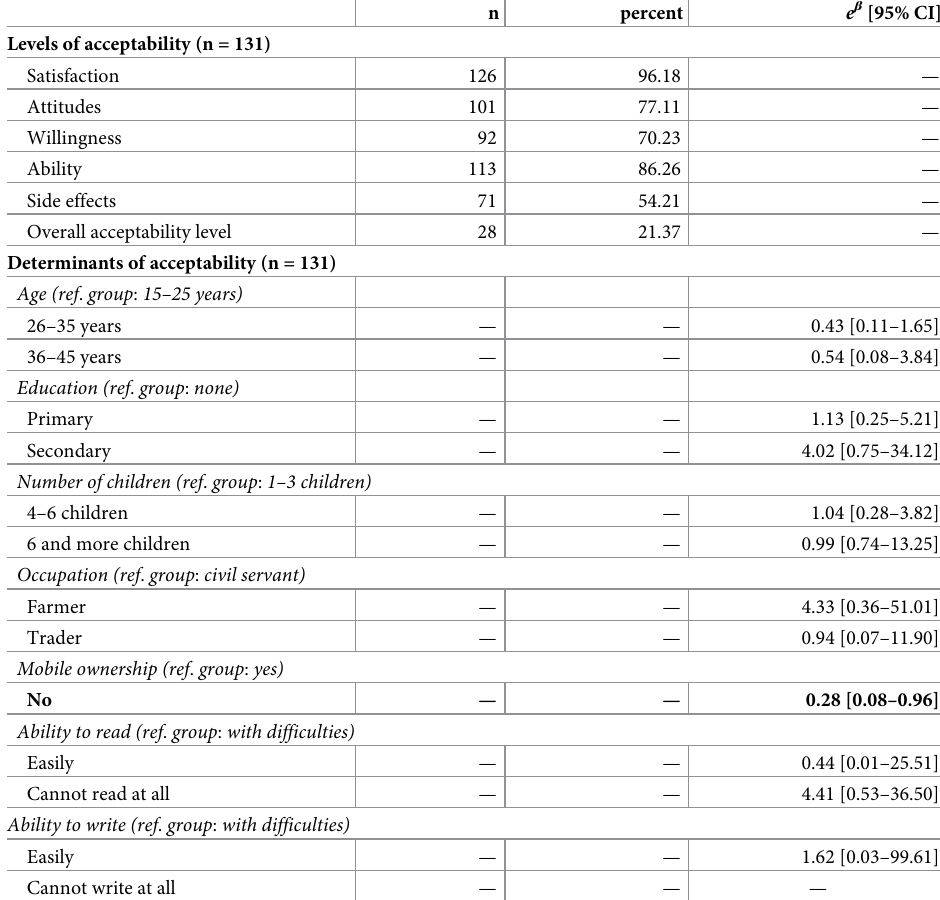
Table 2. Level and determinants of